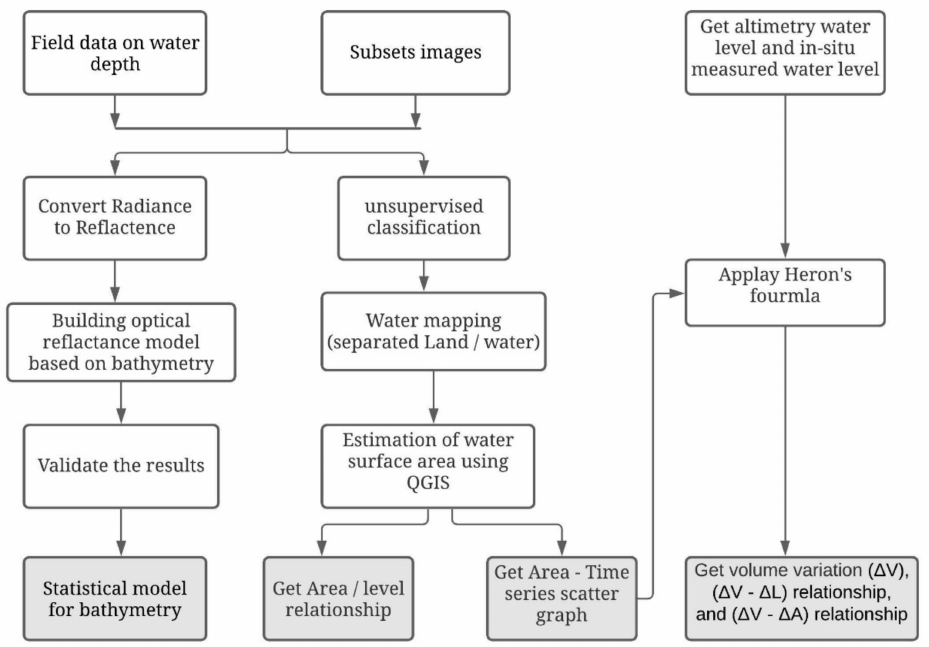
Figure 6. Flowchart showing the processing steps used to estimate water depth, area, and volume variations in AHDL by using Sentinel-3.